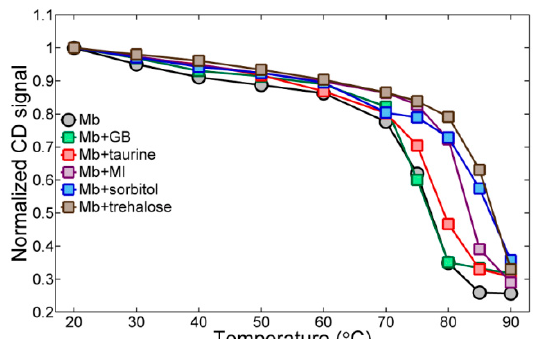
Figure 7. Temperature-dependent CD signal of metmyoglobin backbone in different solutions: 7.0 pH phosphate buffer, 2.0 M sorbitol, 2.0 M glycine betaine, 1.5 M trehalose, 0.9 M taurine and 0.9 M myo-inositol. In the legend, “GB” stands for glycine betaine, and “MI” for myo-inositol. The data was normalized by dividing by the minimum CD signal value. Data shown is taken at the 222 nm wavelength, which is the minimum of the backbone signal.